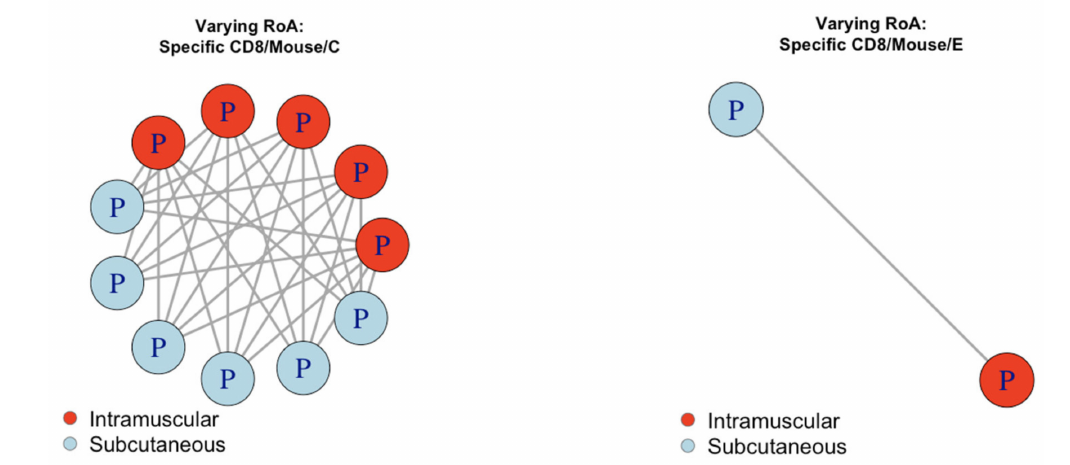
Figure 6. Pairings that di ff ered in RoA species examined for analysis of consistency between groups. Each point represents a dataset that provided evidence, where P / S denotes the dataset had evidence towards a peaking / saturating shape, respectively. Datasets were colour coded according to their Route of Administration. A solid line shows consistent pairings and a dashed line shows inconsistent pairings. C = species C adenoviral vector. E = species E adenoviral